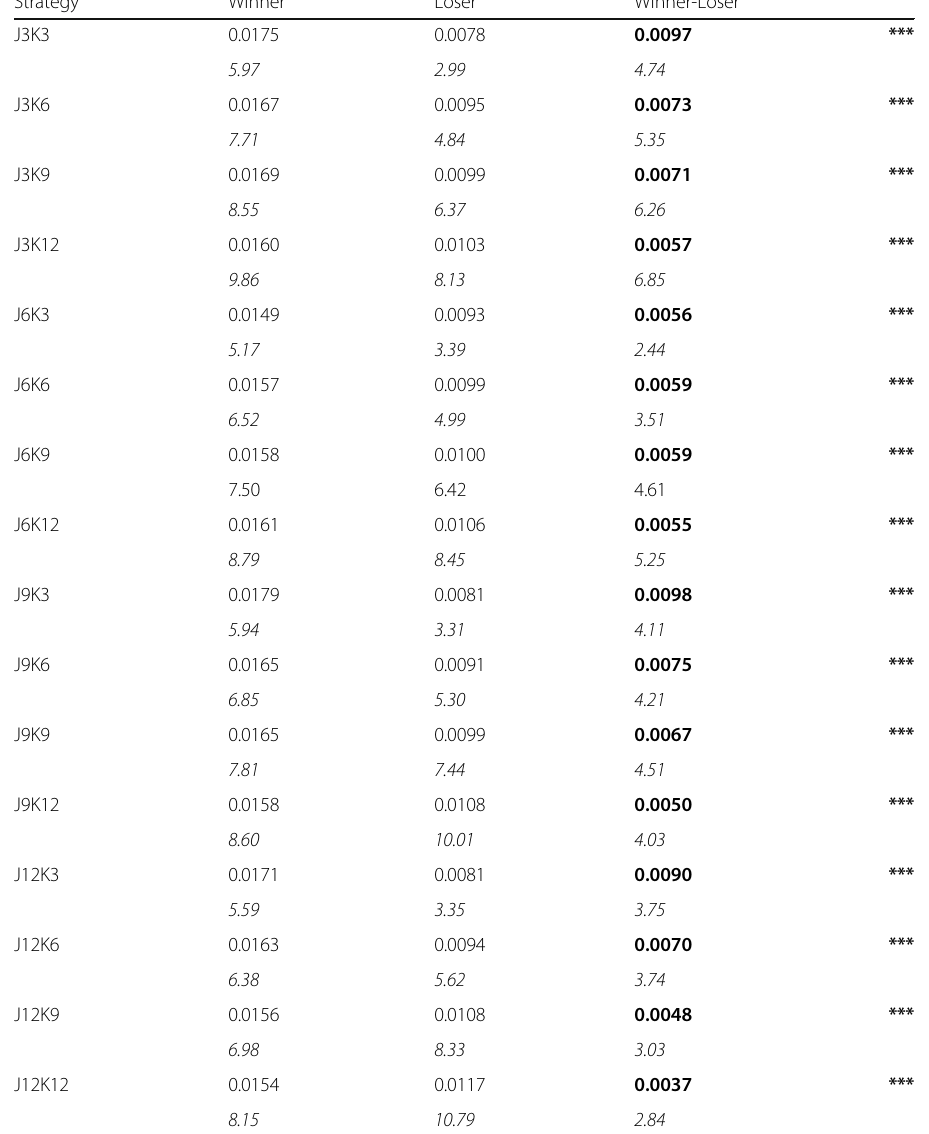
Table 3 Performance of Industry Momentum Trading Strategies (September 1995 to September 2014) Strategy